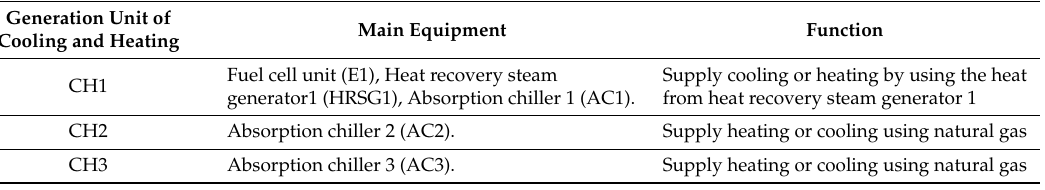
Table 7. The space cooling and heating subsystem of the CCHP system.